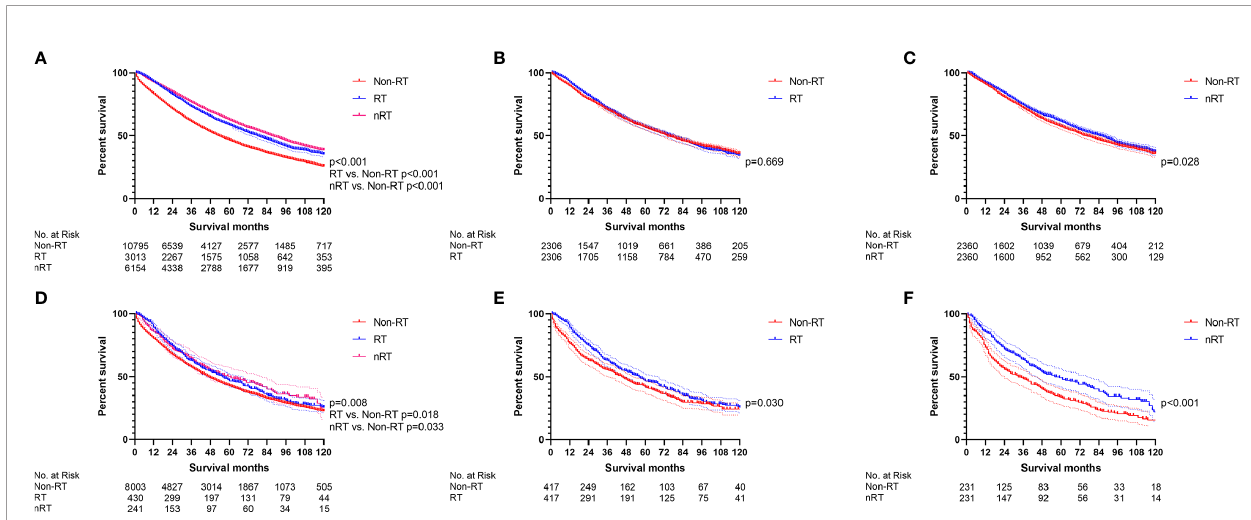
FIGURE 7 | The survival curves were utilized to indicate the effect of radiotherapy in elderly stage II/III RC patients. (A) The total elderly stage II/III RC patients before PSM. (B) RT vs . non-RT in all elderly stage II/III RC patients after PSM. (C) nRT vs . non-RT in all elderly stage II/III RC patients after PSM. (D) The total elderly stage II/III RC patients without chemotherapy before PSM. (E) RT vs . non-RT in elderly stage II/III RC patients without chemotherapy after PSM. (F) nRT vs . non-RT in elderly stage II/III RC patients without chemotherapy after PSM. (The results of PSM are summarized in Table S6